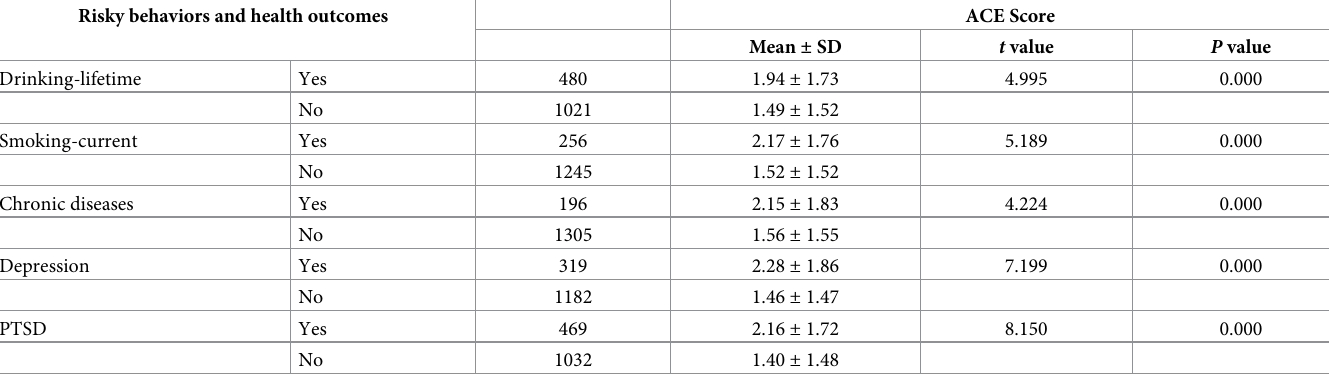
Table 2. Average ACE scores compared between groups with and without health related risky behaviors and health outcomes. Risky behaviors and health